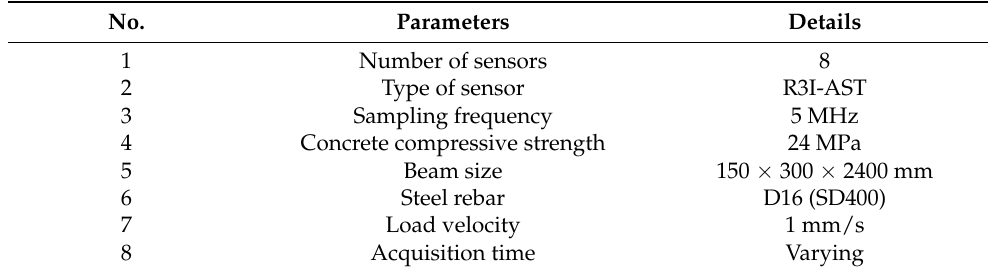
Table 1. Experimental specifications.